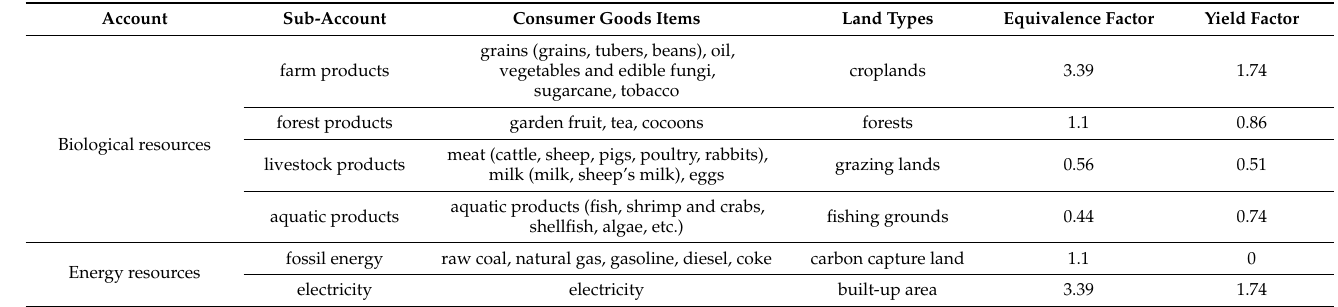
Table 1. Accounting account of three-dimensional ecological footprint of the CUA.